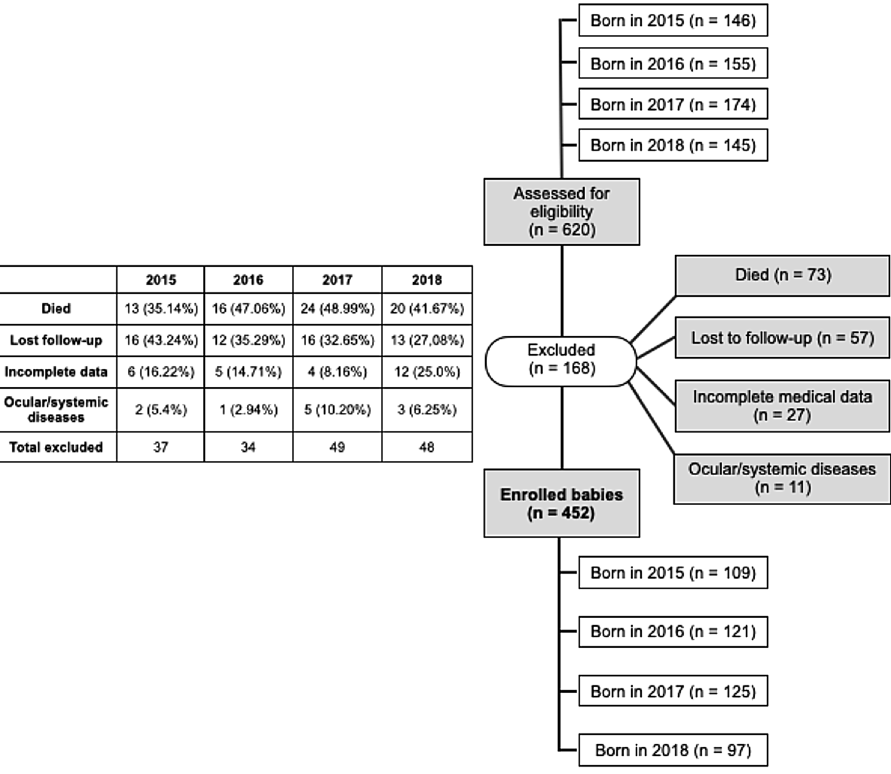
Figure 1. Flow diagram of the study. The chart on the left of the figure shows the exclusion reasons by